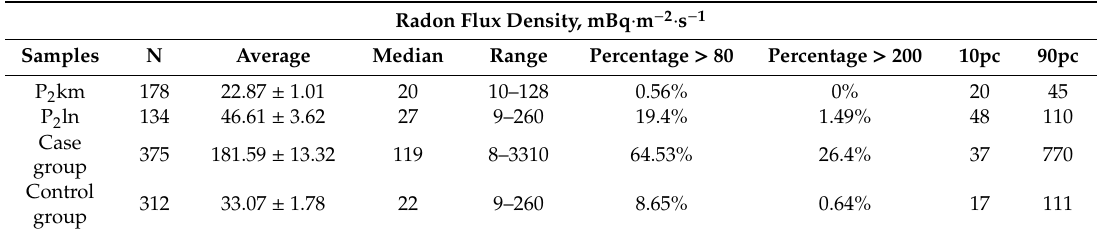
Table 2. The radon flux density for investigated areas.